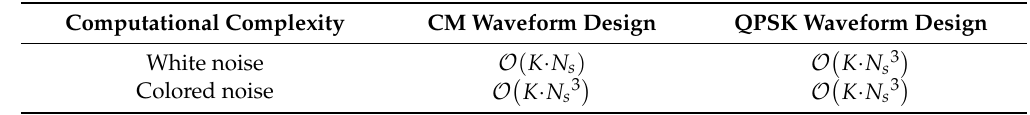
Table 3. Computational complexity of the proposed